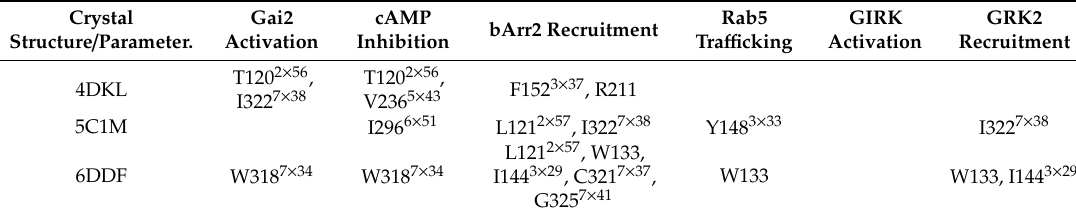
Table 4. Amino acids with the highest values of the Pearson correlation coe ffi cient (above 0.94) between the ligand–residue contact frequency and experimental value (data produced on the basis of the pEC 50 values of selected agonists for some of the pathways measured at the µ opioid receptor gathered in Gillis et al. [31]).